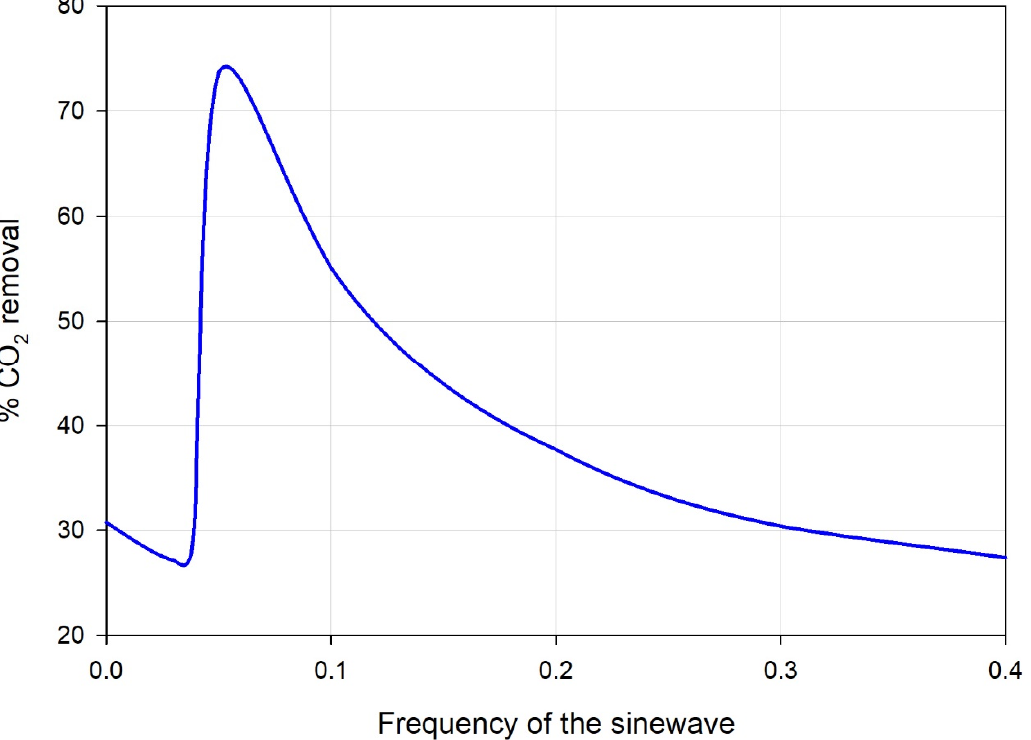
Figure 5. Effect of the sinewave frequency in the feed stream on the percent removal of carbon dioxide from the natural gas stream. The liquid feed rate is 10 mL/min; the gas feed rate is 500 mL/min.